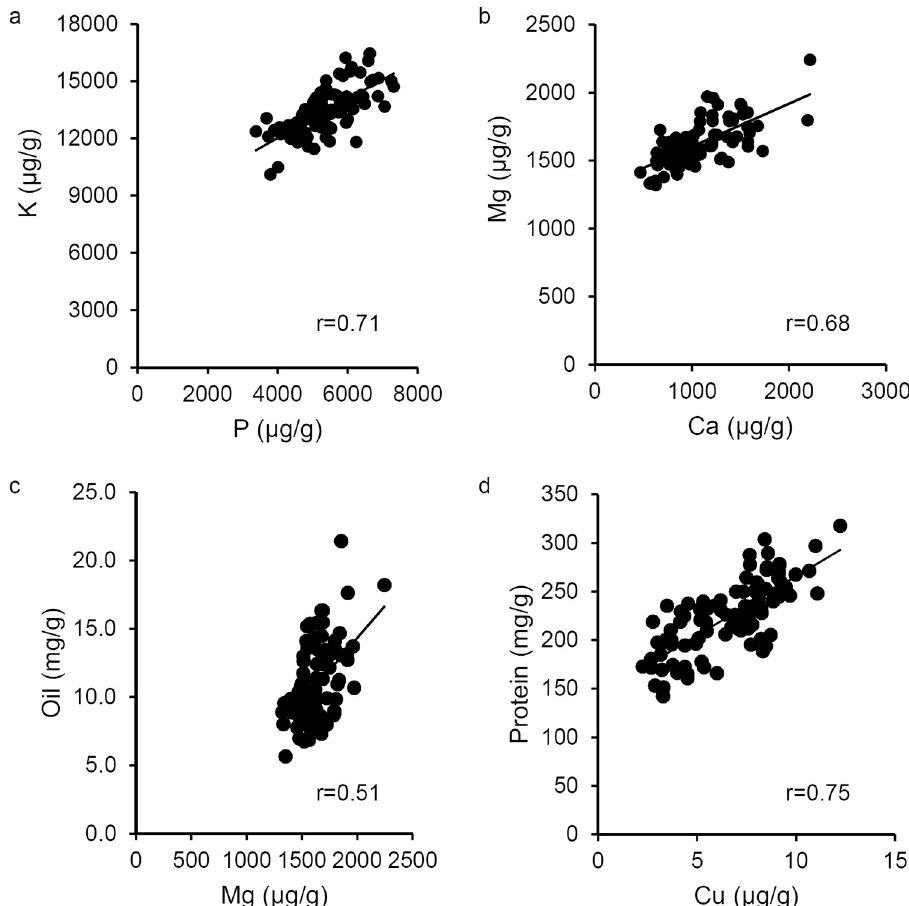
Fig 2. Examples of correlated seed traits. Each scatterplot shows a linear regression trend line and reports the correlation coefficient. All correlations shown are significant at p < 0.01. (a) P and K. (b) Ca and Mg. (c) Mg and oil. (d) Cu and protein.